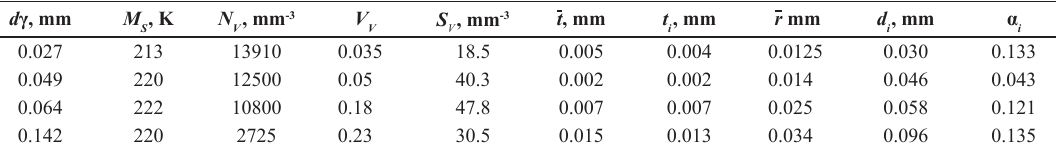
Table 3. Fe-31wt%Ni-0.02wt%C ally - initial bursts – Experimental 26-28 and calculated microstructure descriptors with Equations 3-5 . d γ,